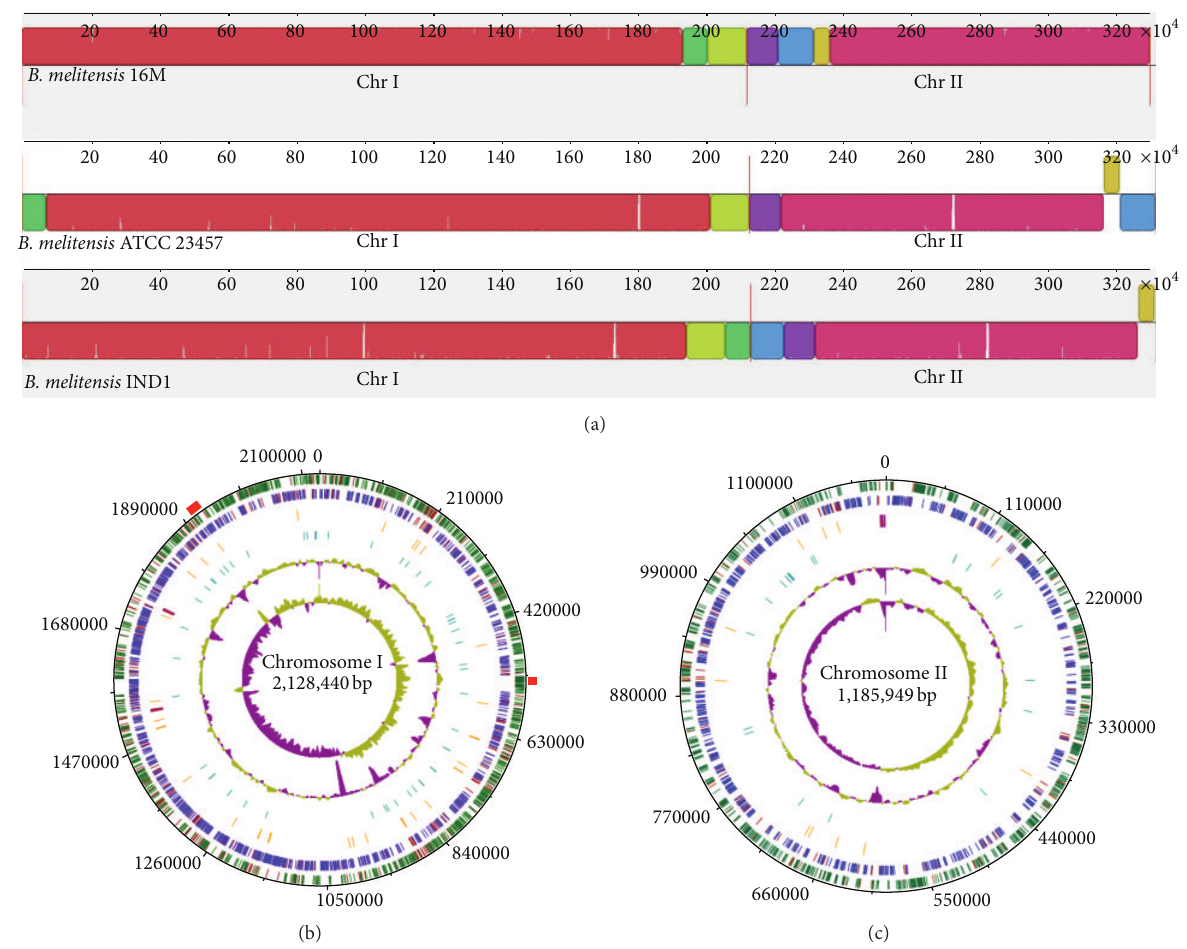
Figure 2: (a) Alignment of B . melitensis 16M, B . melitensis ATCC 23457 and B . melitensis IND1 genome. Mauve alignment shows the synteny regions between the three strains. Bm IND1 and B . melitensis ATCC 23457 aligned well with each other; however, a segment (olive color block) on Chromosome II of Bm IND1 is in reverse orientation in B . melitensis 16M. ((b) and (c)) Circular representation of B . melitensis IND1 Chromosome I (b) and Chromosome II (c). Chromosomal coordinates are indicated on outer most circle. Circles are represented from outer to inner as circle 1, CDS on the positive strand (green for annotated, red for hypothetical); circle 2, CDS on negative strand (blue for annotated, red for hypothetical); circle 3, RNA genes (orange for tRNA and purple for rRNA); circle 4, VNTRS (turquoise); circle 5, GC content (olive for positive and purple for negative); circle 6, GC skew (olive for positive and purple for negative). Red blocks above circle 1 represent phage integration site in Chromosome I.